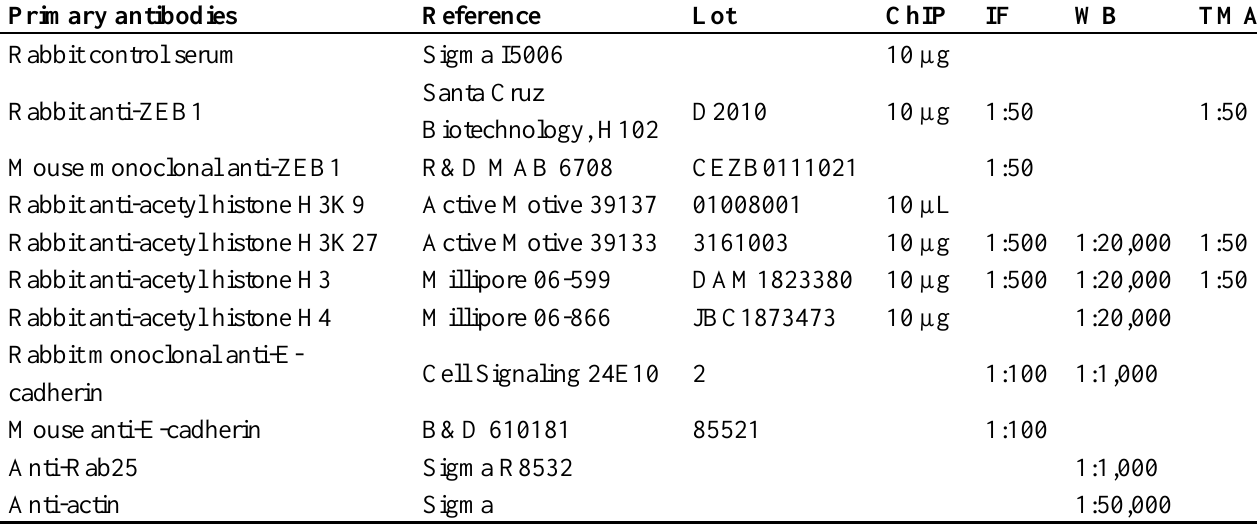
Table 2. Antibodies for ChIP, western blot, immunocytochemistry, and immunohistochemistry. References, quantities and working dilutions are indicated. IF: immunofluorescence, WB: western blot, TMA: tissue